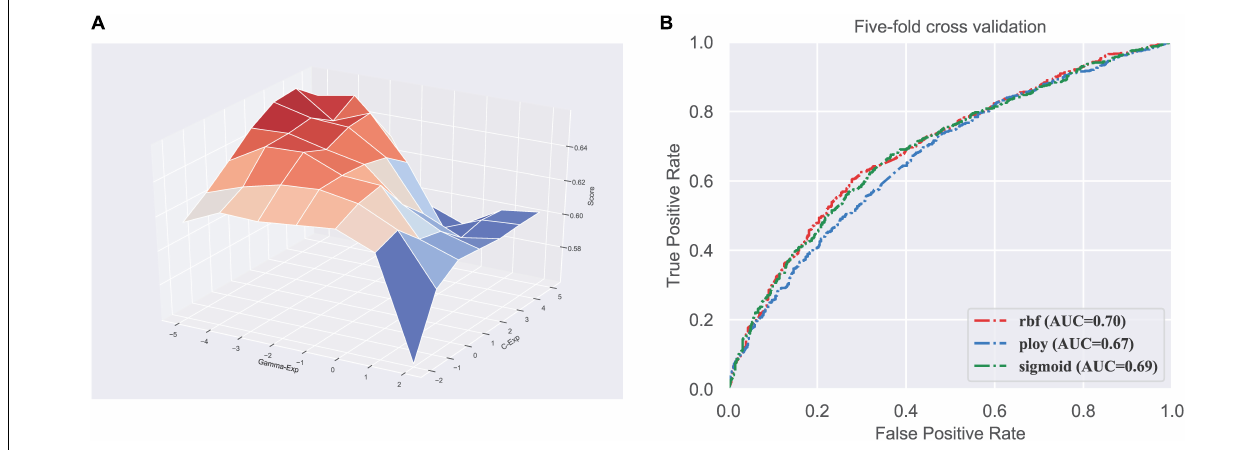
FIGURE 1 | Parameter and kernel optimization of the SVM. (A) Visualization of classifier parameter optimization based on grid search; (B) ROC curves of different kernels in SVM.